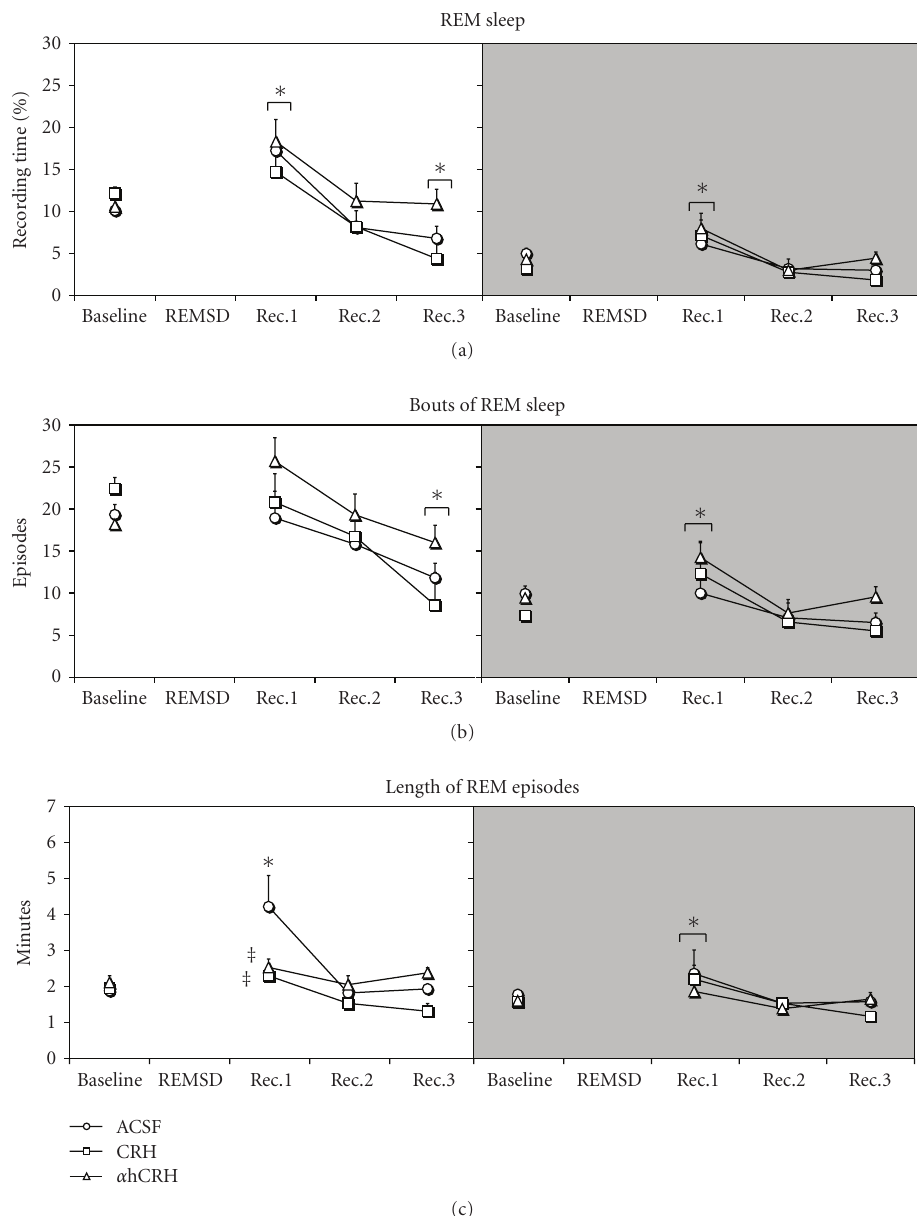
Figure 3: REM Sleep . Data were obtained in recording periods of approximately 11 hours during the light and dark phases. ACSF, artificial cerebrospinal fluid; CRH, corticotrophin-releasing hormone; α hCRH, alpha helical CRH 9 − 41 ; REMSD, 96 hours REM sleep deprivation period; Rec. Recovery period. The white back panels indicate the light phase and the shaded ones, the dark phase. ∗ - di ff erent from baseline, ‡ - di ff erent from ACSF group. Main e ff ects of day are indicated by connecting lines above the symbols. ANOVA, followed by Newman-Keuls, P ≤ .